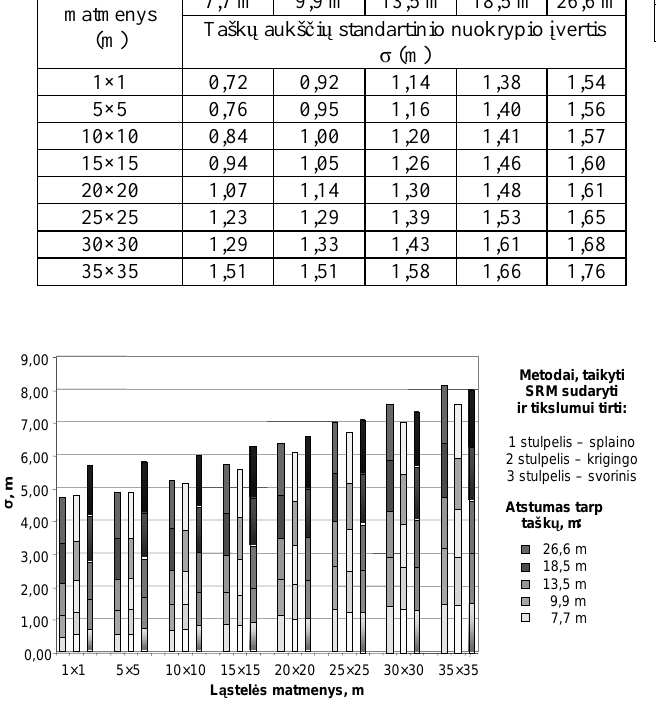
Table 3. Accuracy analysis of DEM created by IDW method Vidutinis atstumas tarp tašk ų